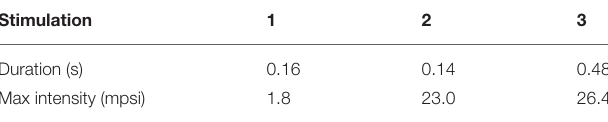
TABLE 2 | Summary table of air puff stimulation characteristics.